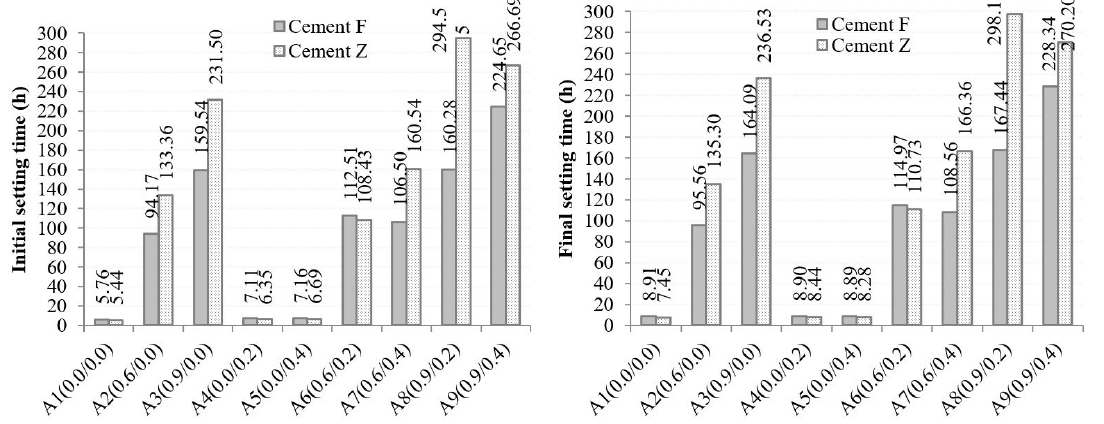
Figure 13. Initial and final setting times for mortars with cements F and Z, by the direct fraction